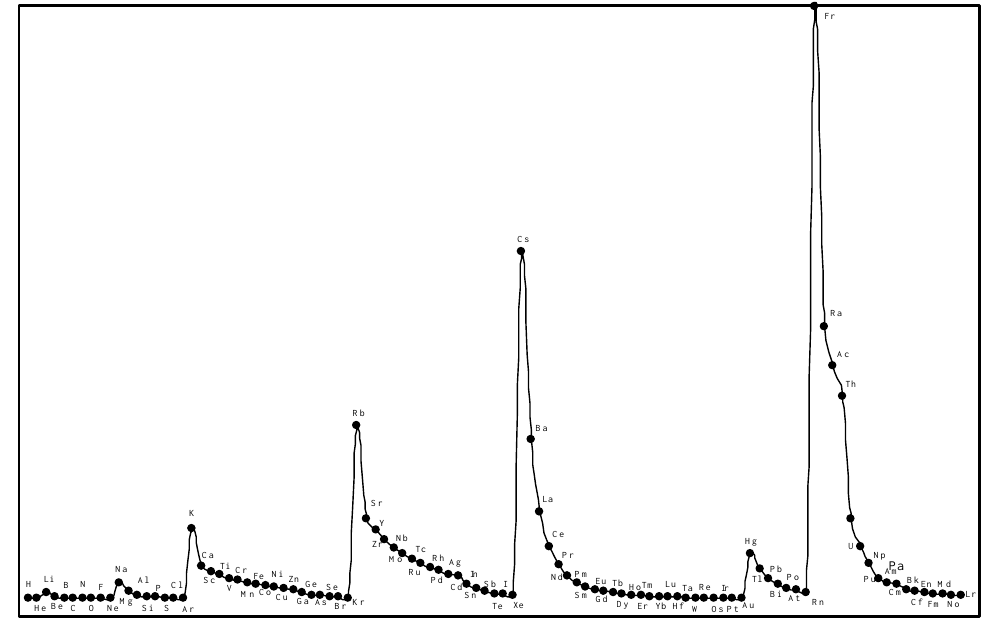
Figure 8. Plot of atomic polarizability (c.c) as a function of atomic